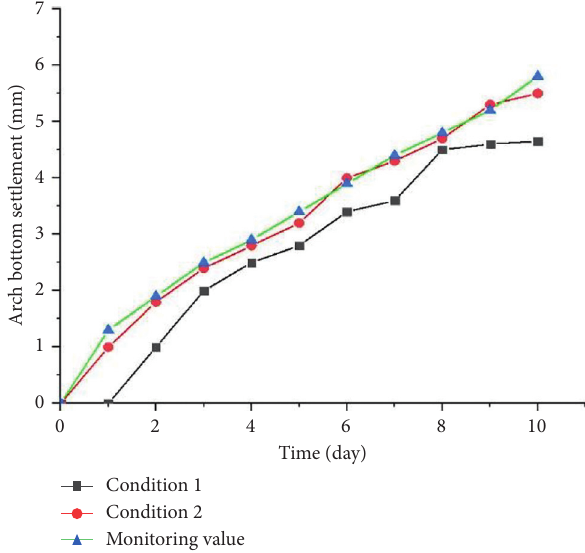
Figure 9: Comparison of calculated and measured